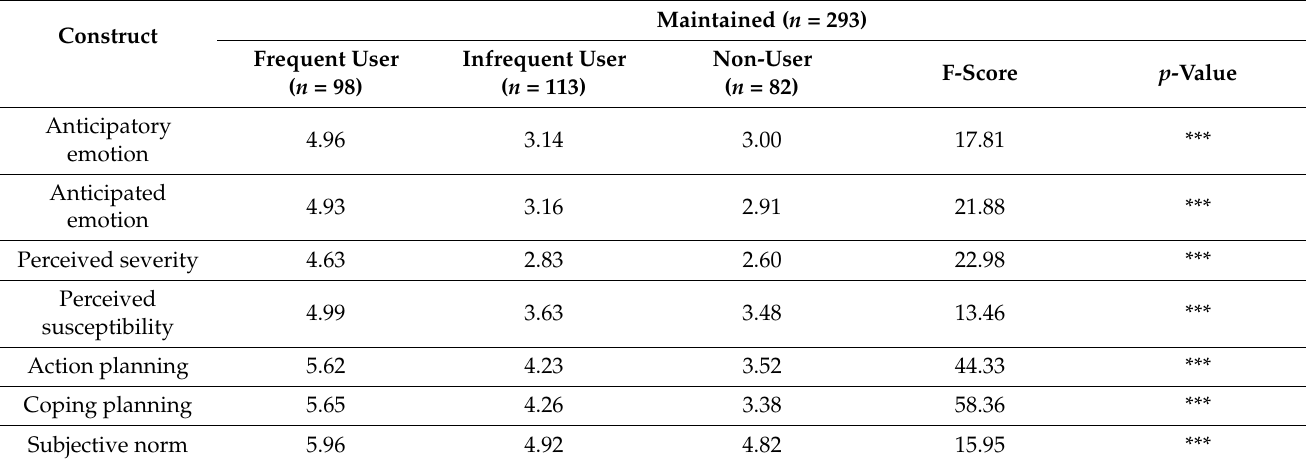
Table 7. Heterogeneity in the maintained users (ANOVA